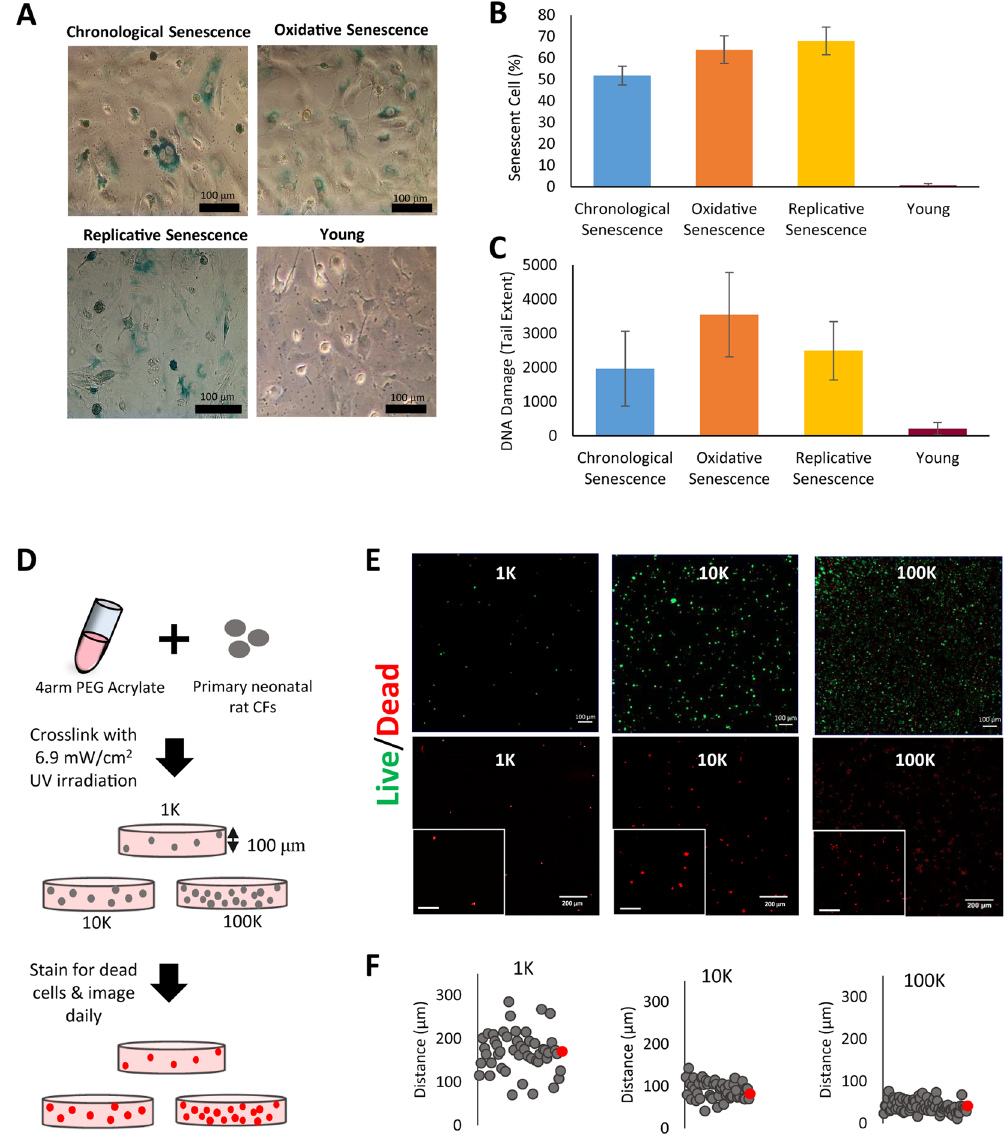
Figure 1. The preparation and characterization of pre-aged cells and fabrication of respective synthetic tissues. ( A ) Senescence marker staining, ( B ) the senescent cell percent, and ( C ) DNA damage in pre-aged and young cells. ( D ) The schematic of fabrication and staining, and ( E ) the day 1 live/dead (top row) and dead cell staining (bottom row) (dead, red = ethidium homodimer-1; live, green = calcein-AM) images of 1 K (day 1), 10 K (day 6), and 100 K (day 8) chronologically aged tissue constructs. ( F ) The cell-cell distance distributions, of the chronologically aged synthetic tissues with 1 K, 10 K, and 100 K population densities (red dot represents the average cell-cell distance). (Scale bars = 100 µ m for live/dead images and inset images, and 200 µ m for dead cell